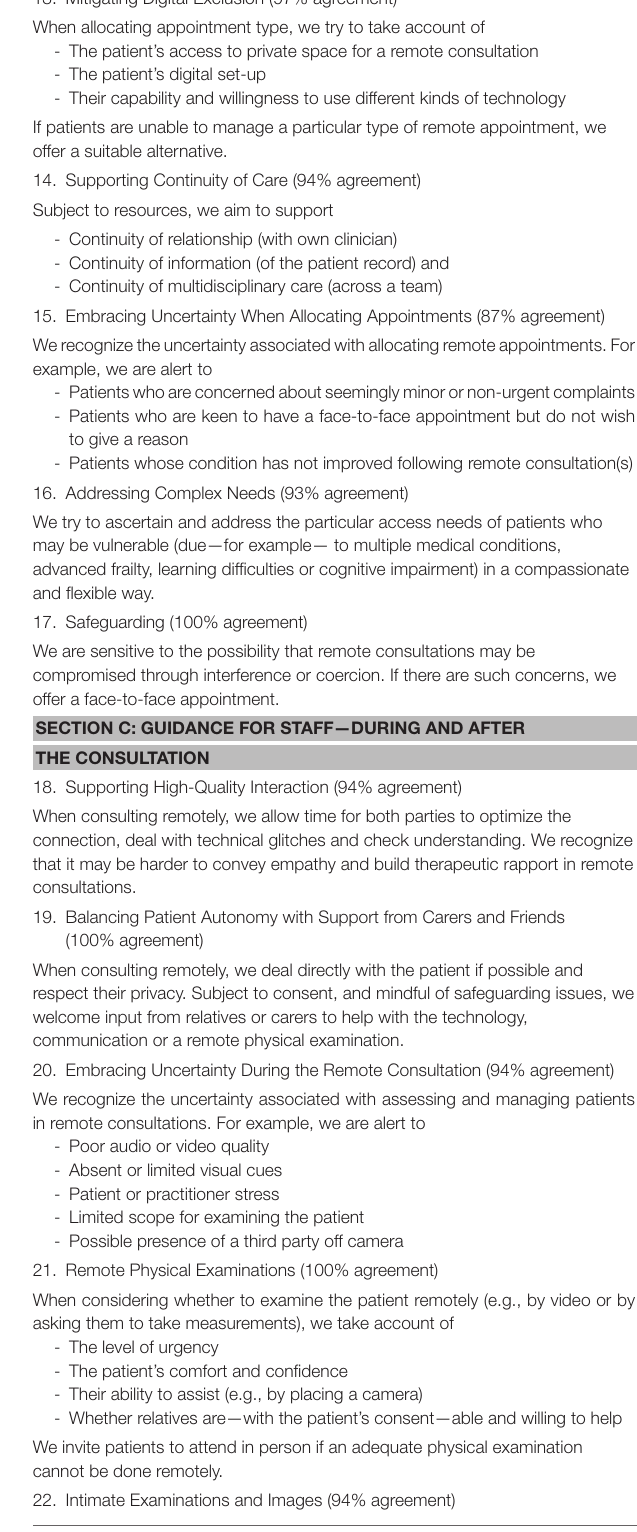
TABLE 3 | Guiding principles to inform application of the PERCS framework. SECTION A: PRINCIPLES UNDERPINNING OUR REMOTE